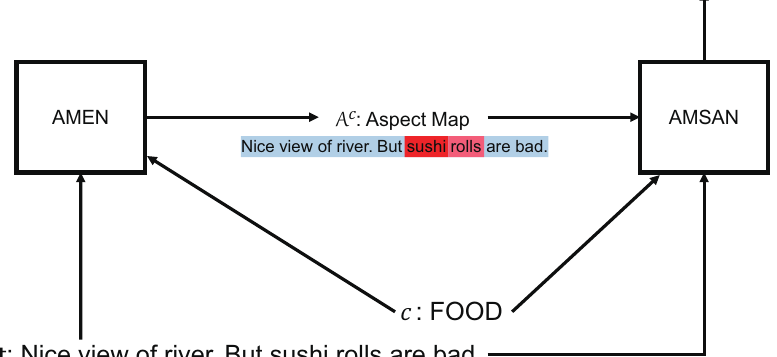
Figure 3. Overall process to determine the aspect-level sentiment polarity by the proposed model. Background colors depict an aspect map that indicates the relevance of each word to the aspect FOOD . Blue color means that a word is almost irrelevant to c . Red colors mean that a word is relevant to c as strong as the color